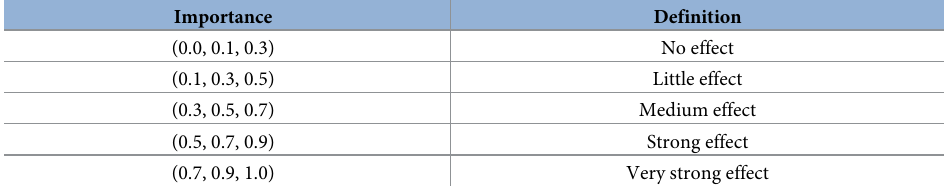
Table 2. Fuzzy continuum and DEMATEL technique, source